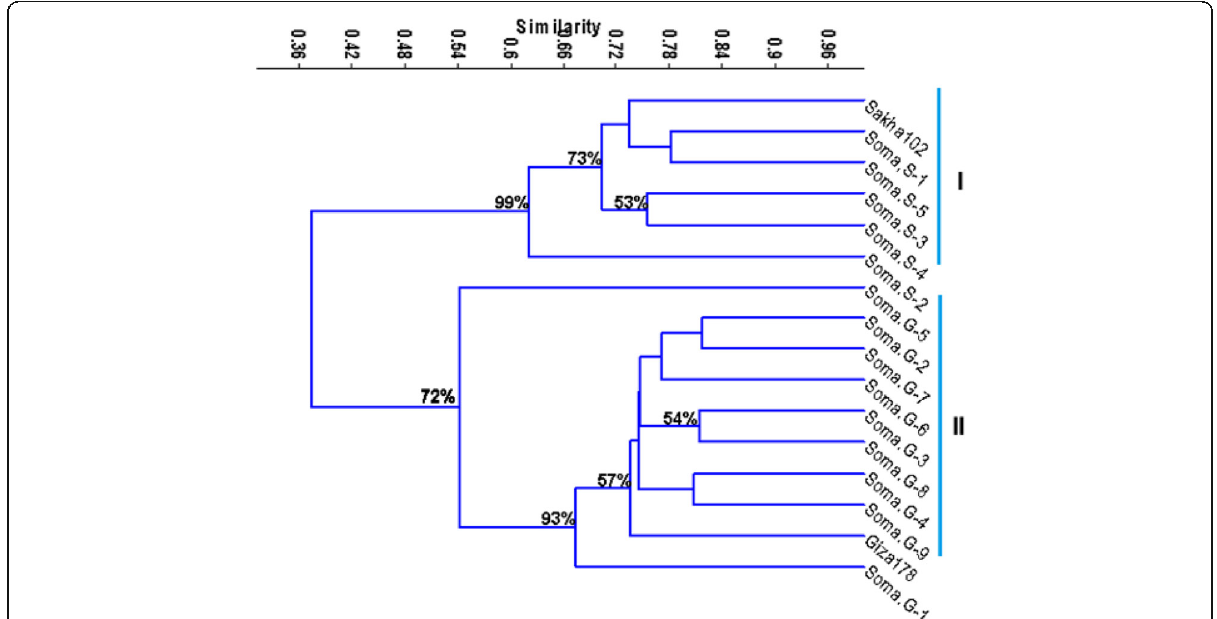
Fig. 4 Dendrogram of rice cultivars and somaclons based on genetic distance obtained from RAPD markers using the UPGMA method. Numbers on branches correspond to bootstrap values % (1000